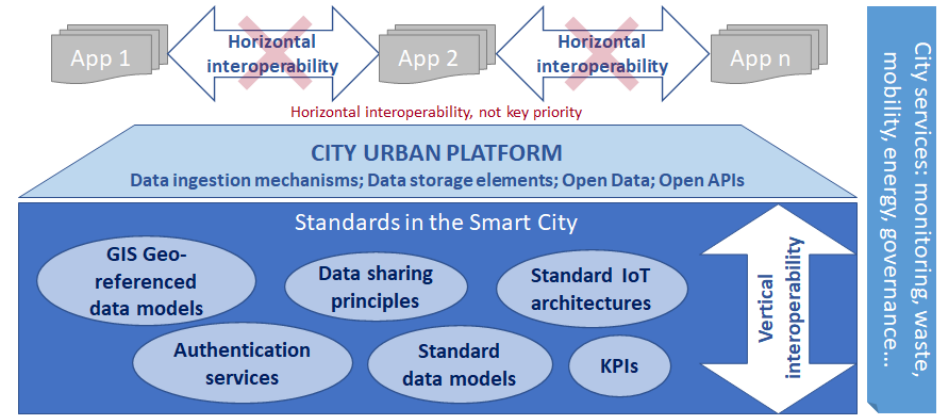
Figure 1. High level overview of the urban platform (approved by the DG CNECT)